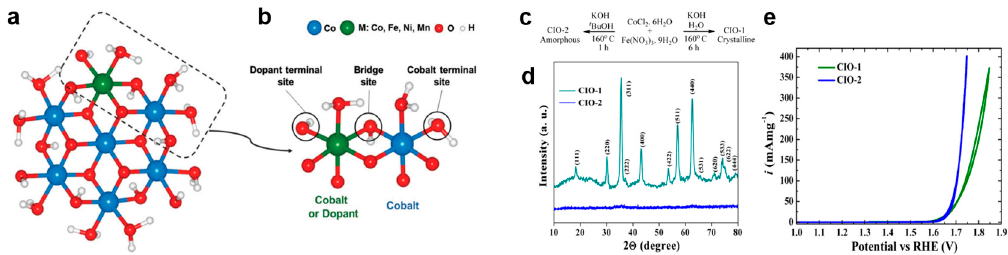
Figure 12. ( a ) Original or Fe-doped Co oxide cluster model with the composition Co 6 FeO 24 H 27 . ( b ) The part of the cluster containing the oxygen sites regarded as the OER mechanism simulation. The cobalt terminal site represents the terminal oxygen connected to the Co ion, located at the second coordination range of the dopant. The dopant terminal site represents the terminal oxygen connected to the doped Fe. The bridge site represents the µ 2-O bonding the doped Fe and Co ion, reproduced with permission from [68]. Copyright CCC Republication, 2018. ( c ) Synthetic process for the fabrication of the electrocatalysts CIO-1 and CIO-2; ( d ) powder XRD patterns of CIO-1 and CIO-2. The peaks of CIO-1 correspond to CoFe 2 O 4 spinel whereas no apparent peaks are observed for CIO-2; ( e ) cyclic voltammograms (CV) of CIO-1 and CIO-2 in 0.1 M KOH with a scan rate of 6 mV s − 1 . Reproduced with permission from [69]. Copyright American Chemical Society, 2014.